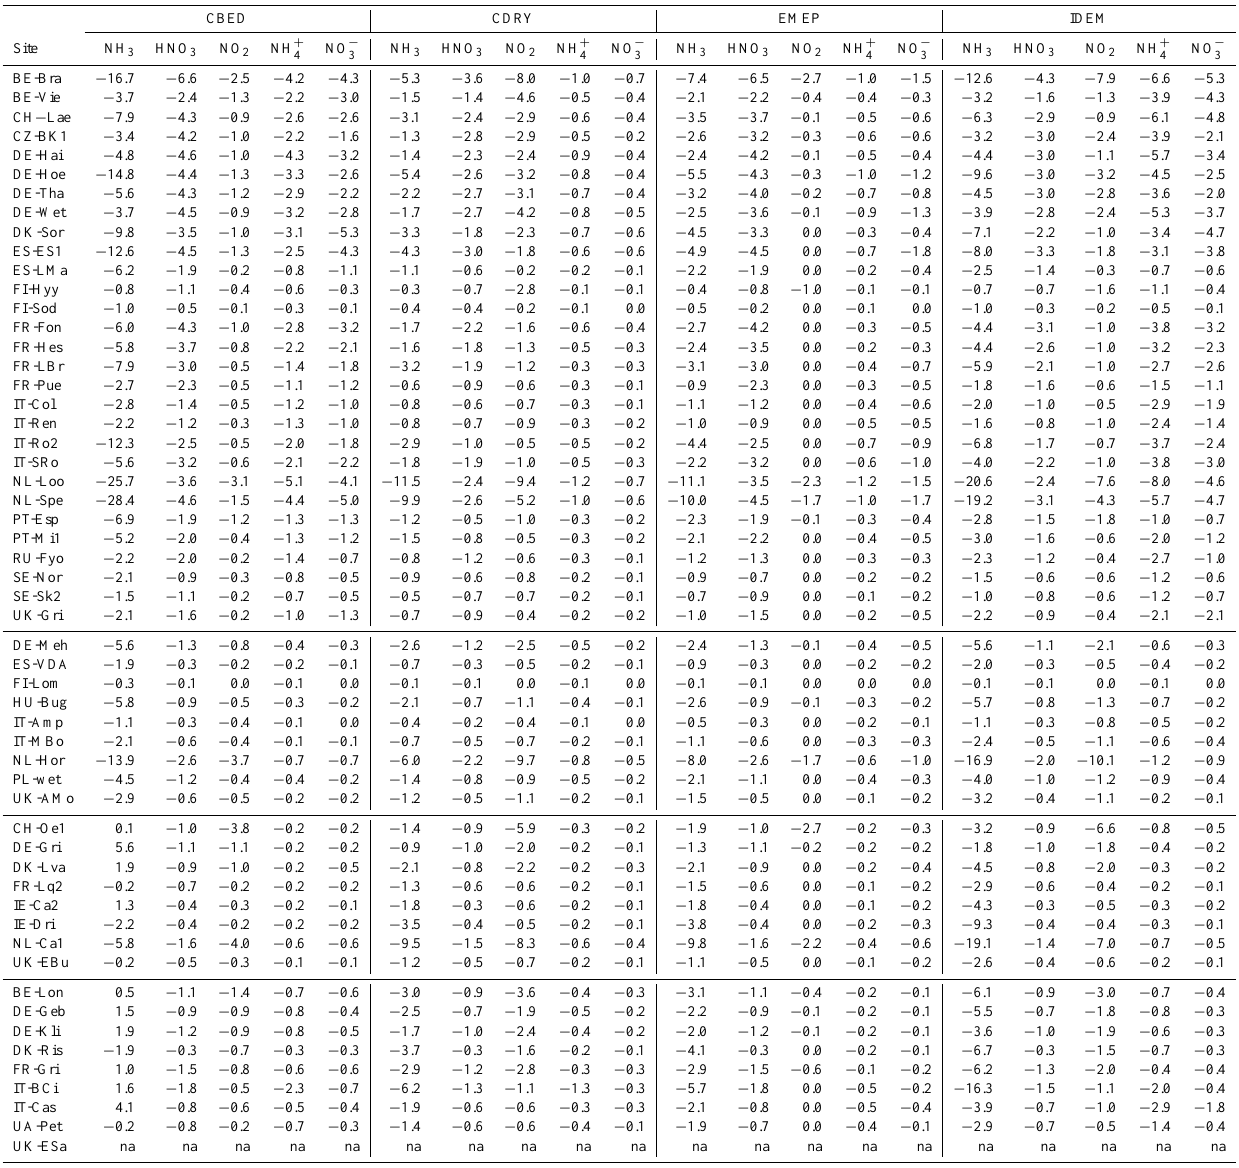
Table 3. Summary of modelled annual dry deposition fluxes to the sites of the NEU inferential network (unit: kgNha − 1 yr − 1 ) , averaged over the two years 2007–2008. A minus “ − ” sign denotes net deposition; positive numbers for NH 3 in CBED indicate a net emission.